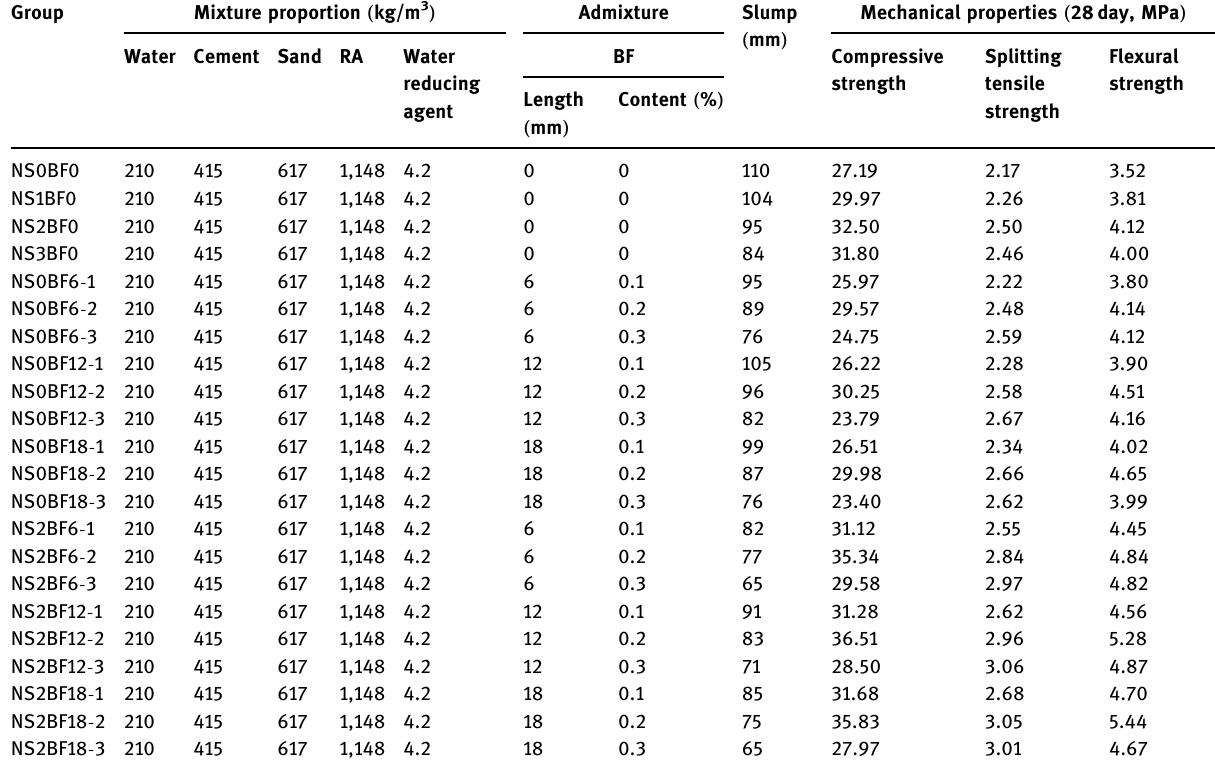
Table 6: Proportion of mixture and various mechanical properties